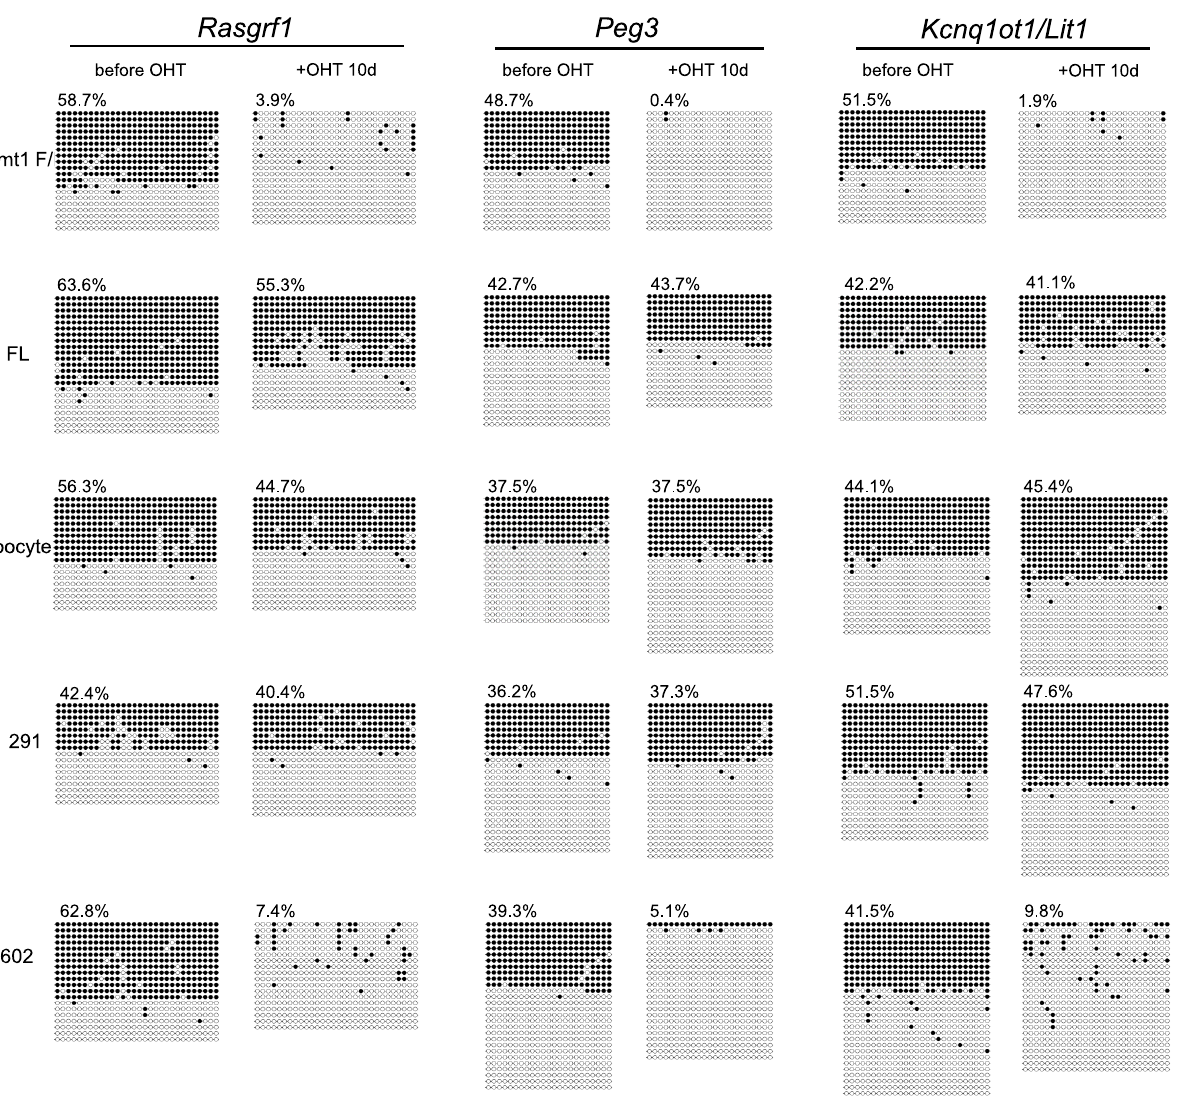
Fig 4. DNA methylation analyses of the DMR of three imprinted genes. The methylation states of the DMRs of Rasgrf1 , Peg3 , and Kcnq1ot1/Lit are shown with that of the parent cells before and after ten days OHT treatment (+OHT 10d). Each horizontal line indicates the CpGs in one analyzed clone. Each circle indicates one CpG site, methylated (filled circles) or un-methylated (open circles). The percentages of methylation are indicated at the